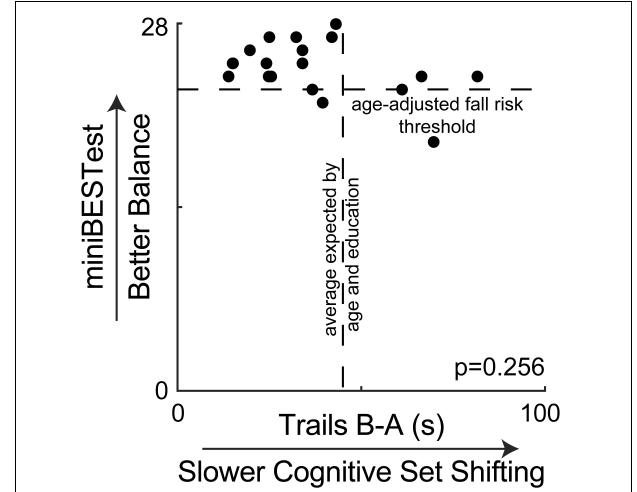
FIGURE 2 | Clinical balance scores are plotted against cognitive set shifting performance, showing no association. Most participants scored above the suggested fall risk cutoff score of 23 for people between 70 and 80 years old on the miniBESTest (Magnani et al., 2020). Most participants also completed the Trail Making Test (B-A) faster than the average of 46 s that would be expected by their age and education from normative data (Tombaugh,